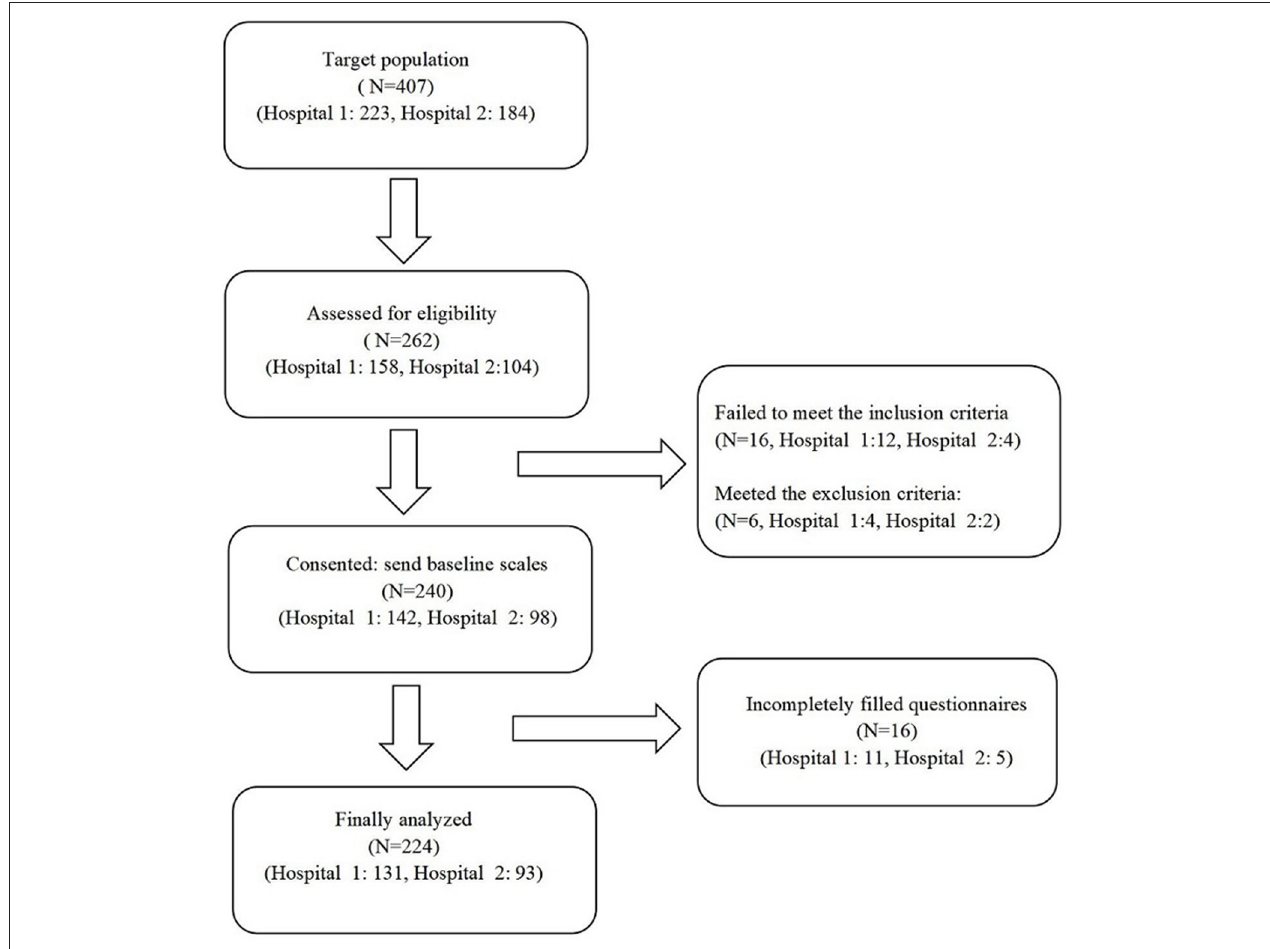
FIGURE 1 | Participant recruitment flow